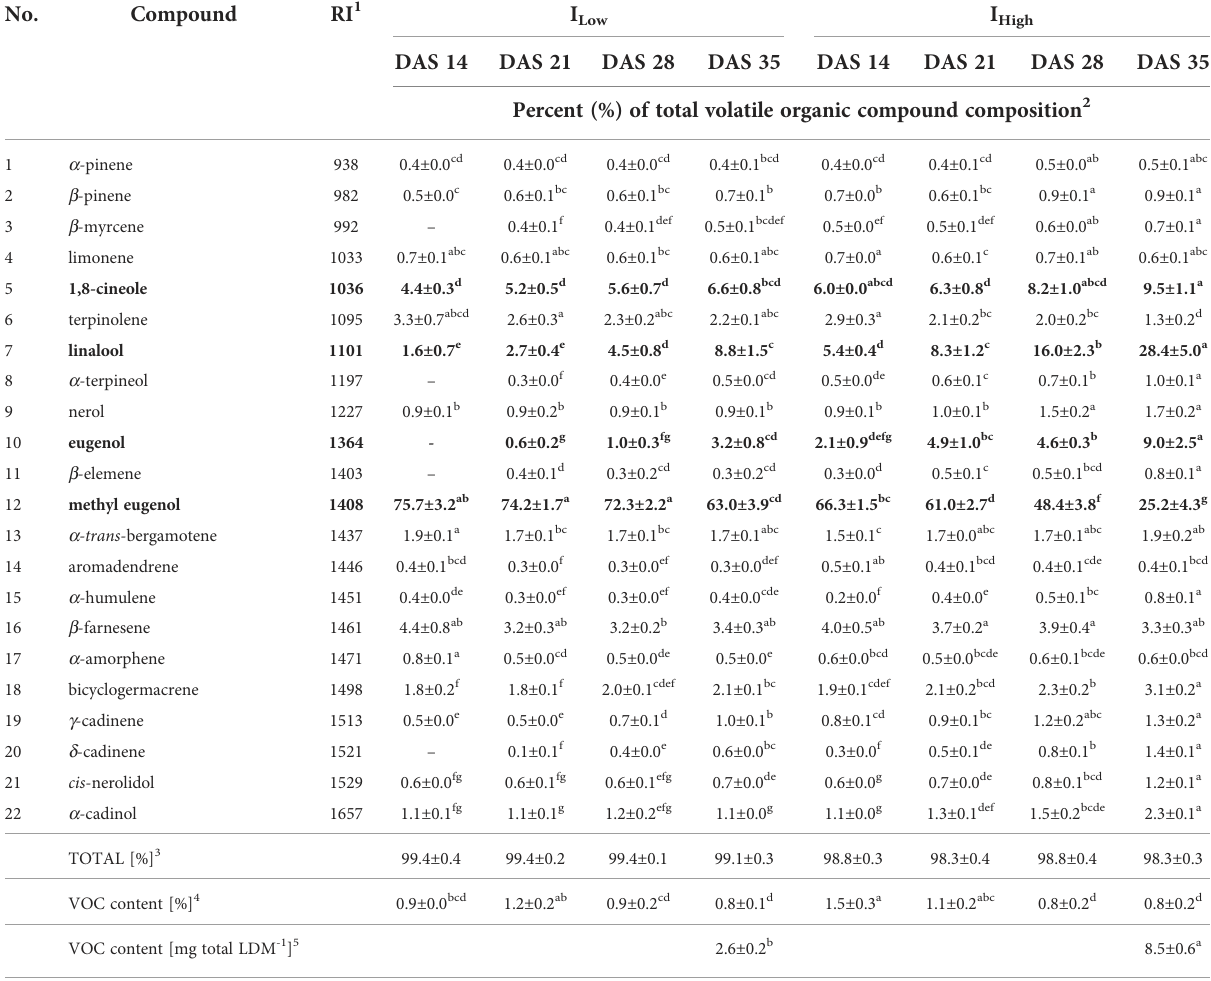
TABLE 4 Relative abundance of major volatile organic compounds identi fi ed in the leaves of O. basilicum L. cv. ‘ Dark Opal ’ as affected by LED light intensity treatments over time.